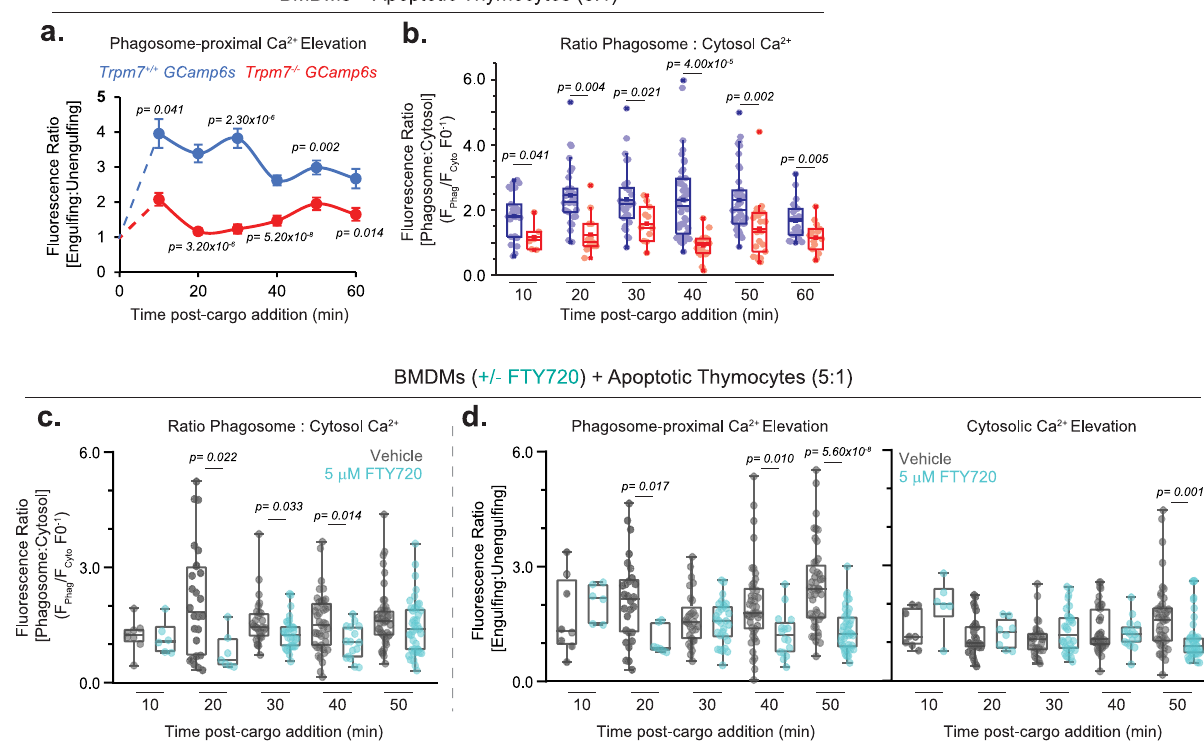
Fig. 9 Phagosome-proximal elevations in Ca 2 + are dependent on TRPM7 during efferocytosis. a Measurement of phagosome-proximal [Ca 2 + ] in WT and KO BMDMs during phagocytosis of apoptotic cells. Changes in fl uorescence of GCaMP6s represent changes in phagosome-proximal Ca 2 + . Data points were collected at indicated time points and measure the MFI in cargo-containing BMDMs relative to the fl uorescence of non-engul fi ng BMDMs in the same fi eld of view. Data points depict mean values; error bars re fl ect SEM ( n > 20 cells at each timepoint). Individual data points are plotted in Supplementary Fig. 6e (left), and statistics were tested at each measured timepoint between genotypes. b Relative changes in phagosome-proximal [Ca 2 + ] during phagocytosis in WT and KO BMDMs. Phagosome-proximal values are relative to the cytoplasmic [Ca 2 + ] within the same cell. Data were measured from the same experiments shown in panel a . Fluorescence ratio re fl ects fl uorescence intensity in an ROI proximal to phagosome relative to the cytosol ROI. Analysis is described in Supplementary Fig. 6a-c and Methods. Data points in the box chart represent individual phagosomes and the mean value is depicted as a horizontal line across the box. See also Supplementary Fig. 6d, e. c Relative changes in phagosome-proximal cytosolic [Ca 2 + ] during phagocytosis with and without treatment with FTY720. Data are as displayed in Fig. 9b. d Relative changes in phagosome-proximal and cytosolic [Ca 2 + ] during phagocytosis with and without treatment with FTY720. Data are displayed as in Fig. 6f, data points in the box chart represent individual phagosomes and the mean value is depicted as a horizontal line across the box. See also Supplementary Fig. 9c. Source data are provided as a Source Data fi le, and statistical testing is described in “ Statistics and Reproducibility ”